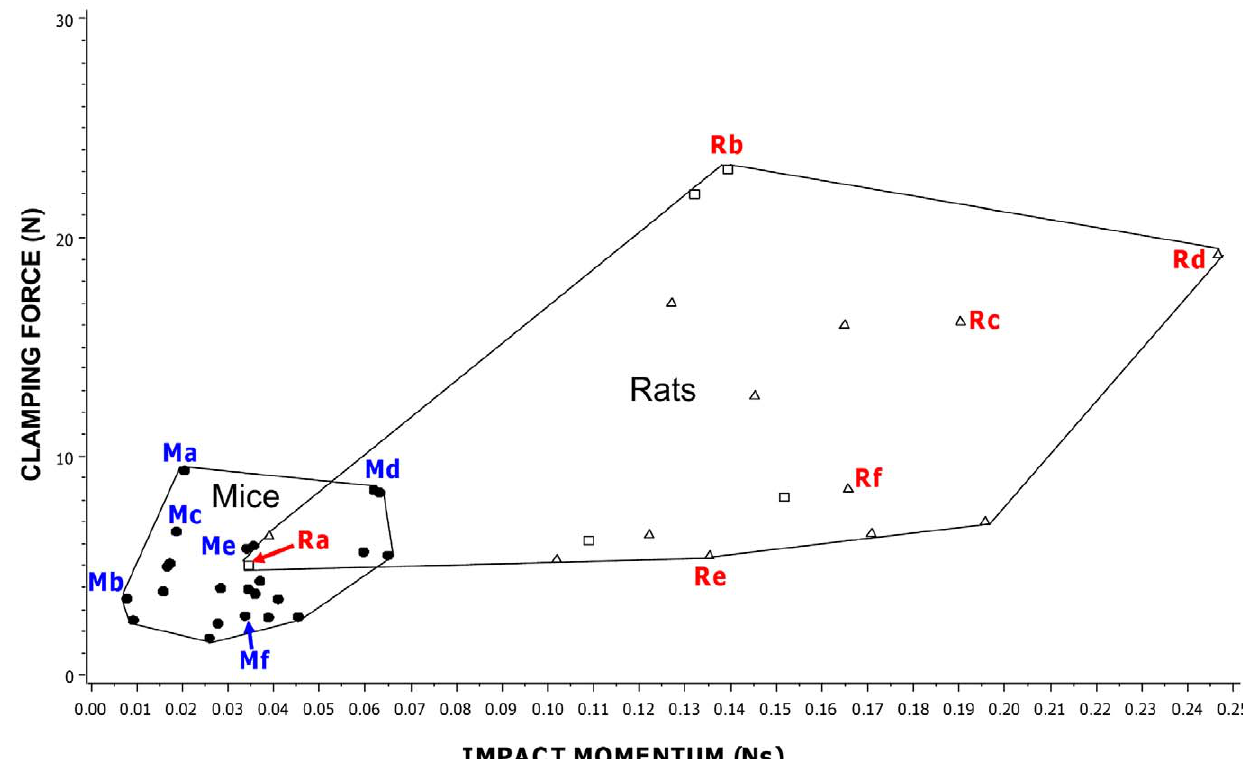
Figure 1. Impact momentum against clamping force for mouse and rat traps. Mouse trap types (n=23) are represented by circles and rat trap types (n=17) by triangles or squares. Each point represents a different trap type and is the mean of five measurements on one trap. [The raw data from which these were calculated are shown in Figure S6.] Points marked Ma-f (labelled blue) and Ra-f (labelled red) are trap types in the mouse and rat replicated sets respectively, with features shown in Table